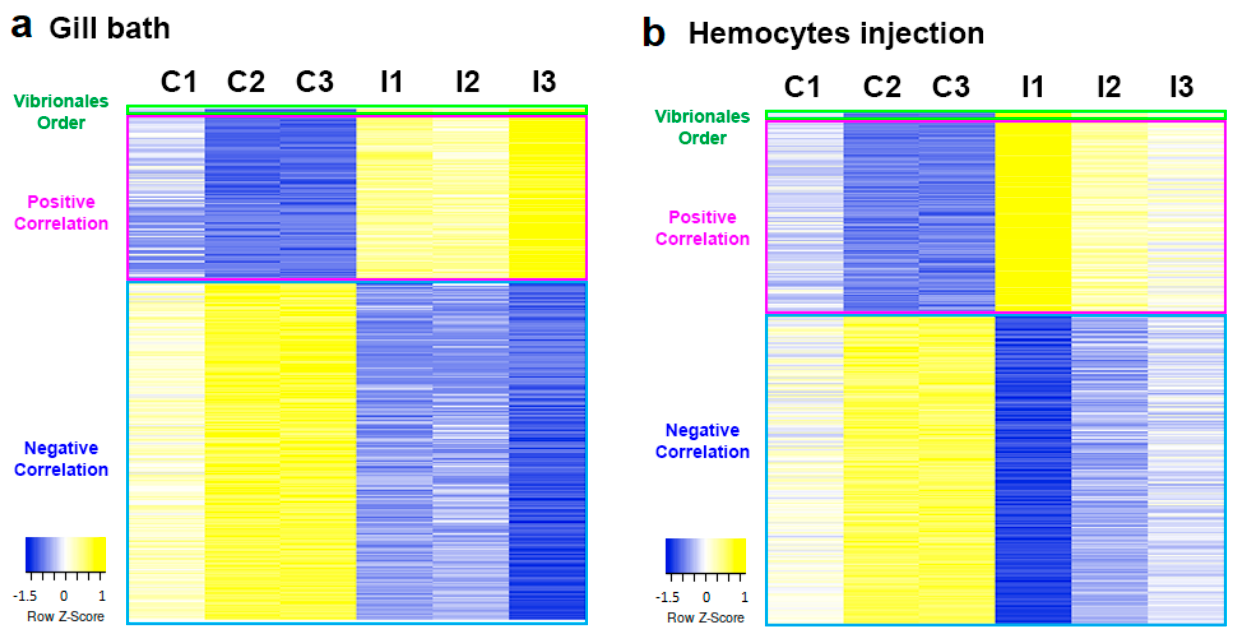
Figure 6. Correlation between Vibrionales abundance and mussel transcriptome data. Heatmaps show Vibrionales order abundance values and TPM values of the highest correlated transcripts (R 2 > 0.90). A logarithmic transformation of the data was performed ((log2(x + 1))). Graph ( a ) corre- sponds to the bath infection experiment [20] and graph ( b ) to the injection experiment [21].